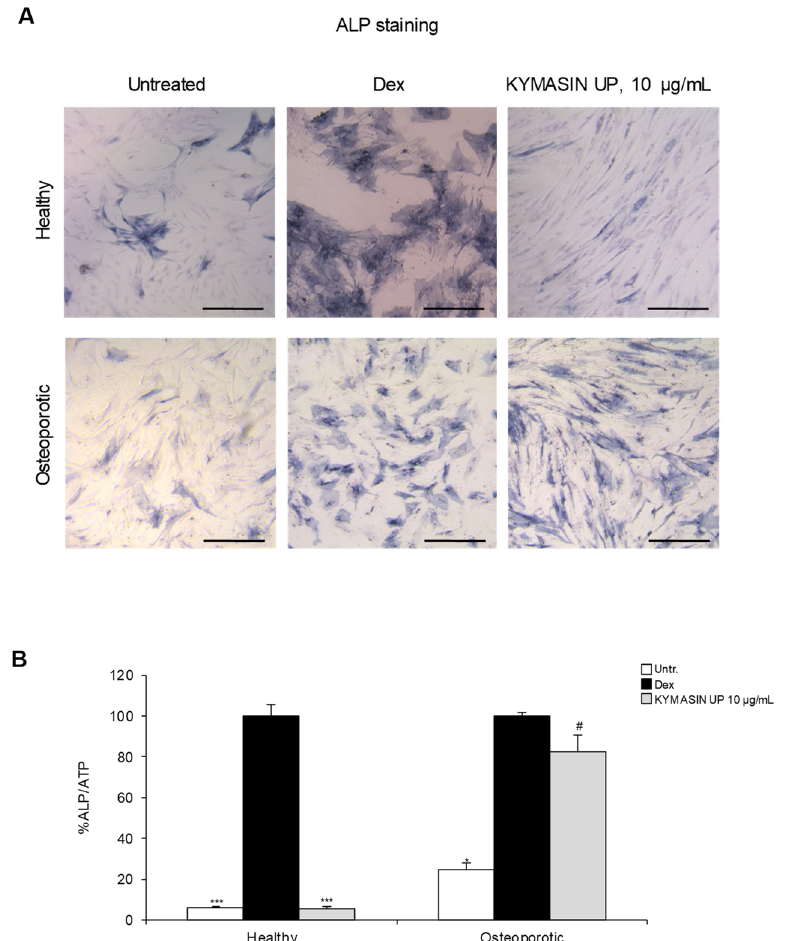
Figure 6. ( A , B ) Pre-OB cells derived from healthy and osteoporotic subjects ( n = 3 each group) were treated for 12 days with KYMASIN UP (10 µg/mL) or with Dex as positive OB differentiation control. ( A ) Representative images of ALP staining are reported. ( B ) ALP activity was measured and normalized to ATP (adenosine triphosphate) as an index of cell numbers and reported as percentages with respect to Dex treatment. Results are means ± standard error of the mean. Statistical analysis was conducted using the two-tailed t -test. * p < 0.05, and *** p < 0.001, significantly different from Dex. # p < 0.05, significantly different from untreated control (Untr). Scale bars ( A ), 200 µm.